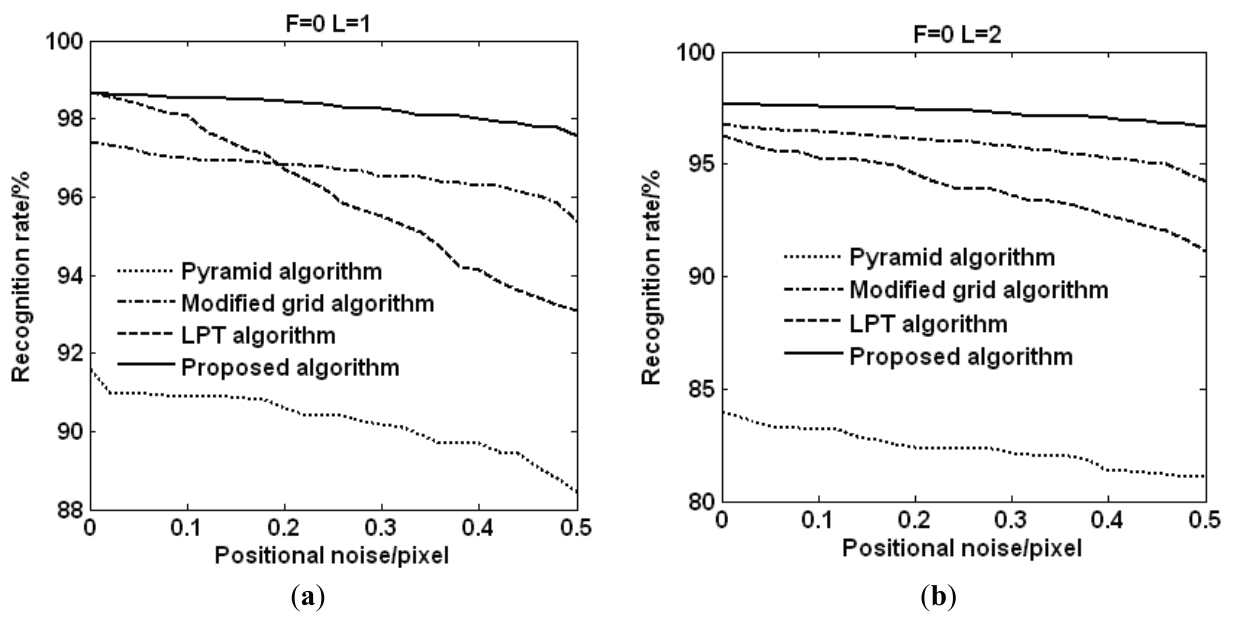
Figure 7. The recognition rates of different algorithm with false stars. ( a ) Recognition rate with 1 lost star; ( b ) Recognition rate with 2 lost stars.